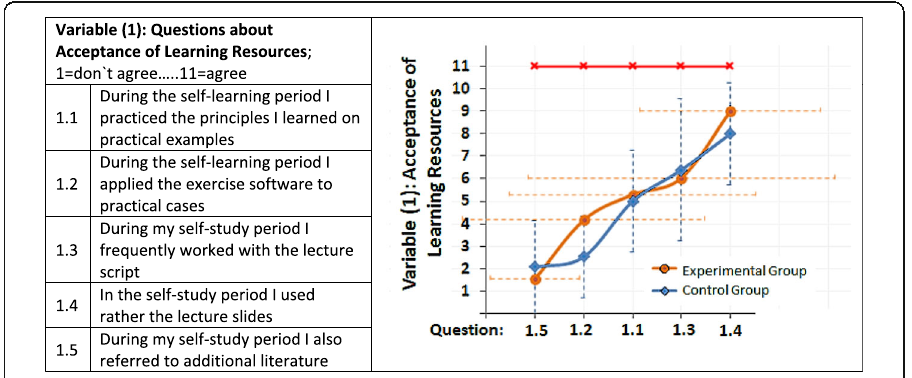
Fig. 3 Post-Test results for Variable (1). Significant ( p ≤ .05) for question 1.2, horizontal line shows theoretical maximum, dotted lines indicate scattering of